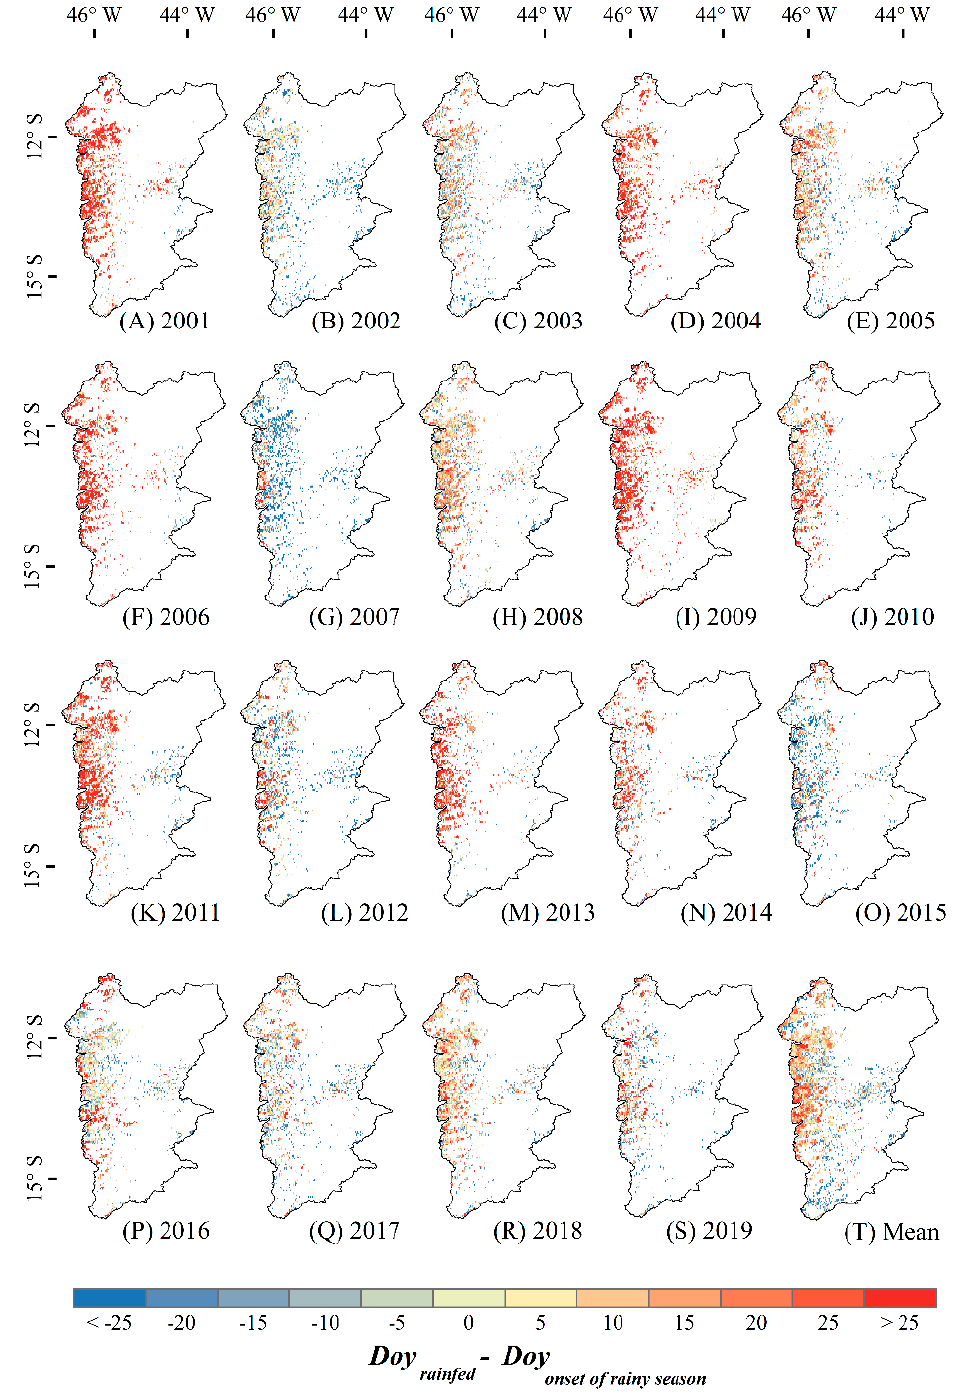
Figure 7. Spatial distribution of the difference between rainfed sowing dates and rainy season onset from 2001 to 2019 ( A – S ). Panel ( T ) shows the average anomaly for each pixel.